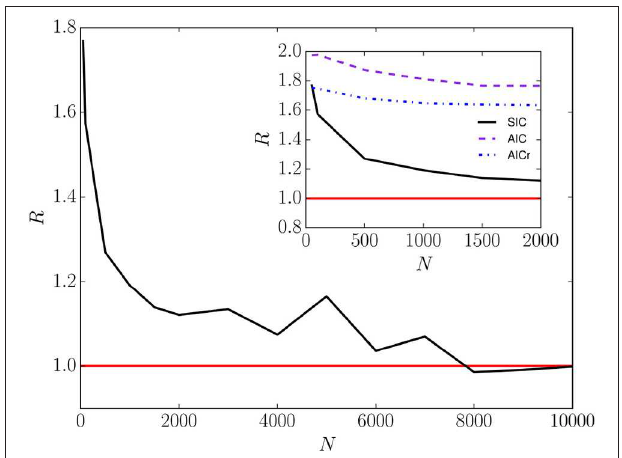
TABLE 2 | Scaling laws t conv